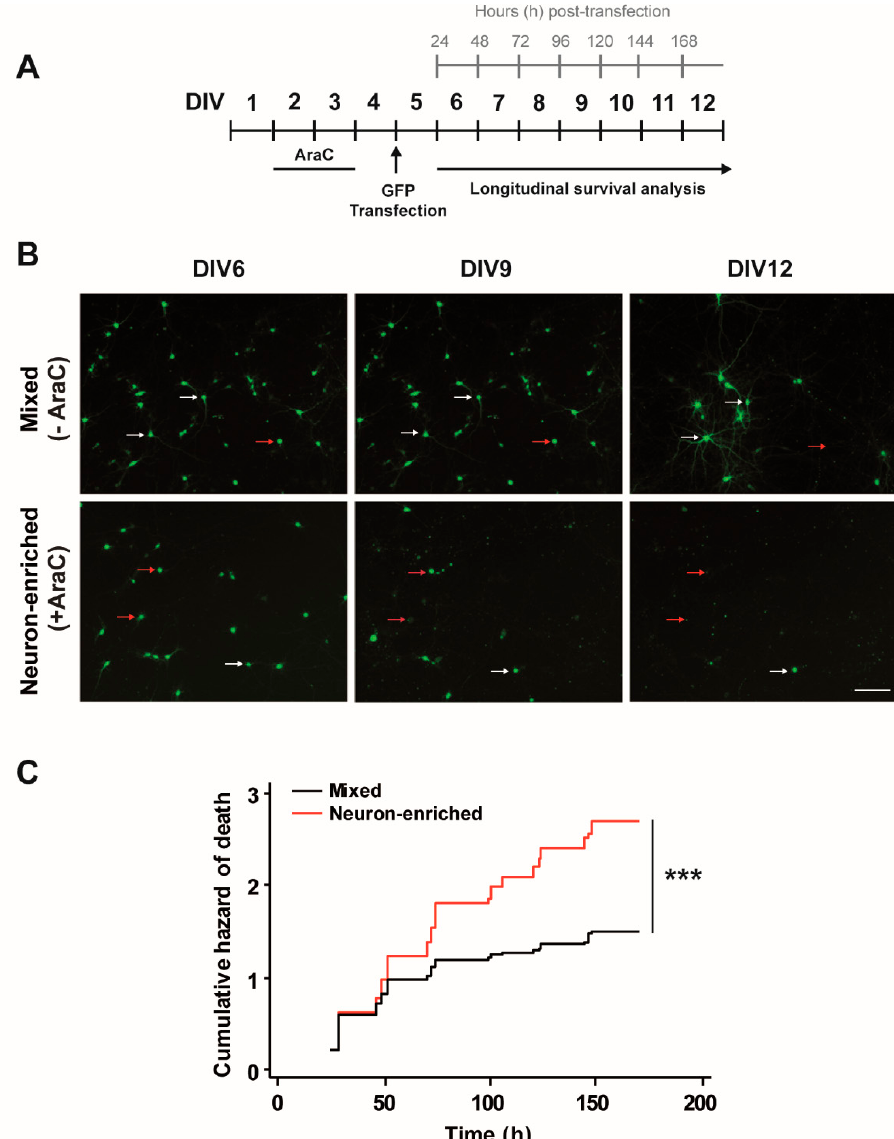
Figure 2. Glial cells are necessary for neuronal survival. ( A ) Diagram showing the experimental design. Rat primary cortical cultures were prepared and 10 μ M AraC was added at DIV2 for 48 h to prevent cell proliferation. DIV5 neurons were transfected with GFP and their fate was followed until DIV12. Image acquisition was performed every 24 h after transfection. Red arrows point out to neurons that die along the experimental time whereas white arrows point out to neurons that survive until the end of the experiment. ( B ) Longitudinal monitoring by automated microscopy of individual rat cortical neurons transfected with GFP in the presence and absence of AraC. Magnification bar: 100 μ m. ( C ) Cumulative hazard estimates of GFP-transfected neurons from mixed ( − AraC) and enriched (+AraC) neuronal cultures. Log-rank test, mixed = 1549 and neuron-enriched = 679 neurons respectively from three independent experiments, *** p < 0.001.